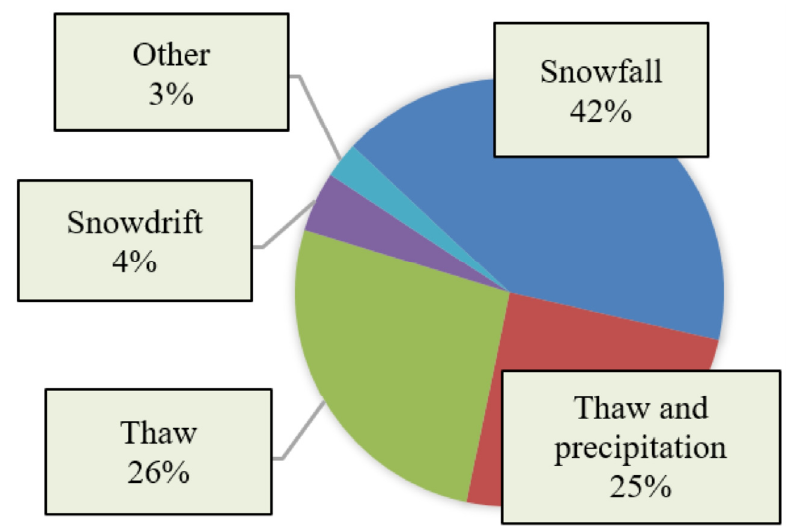
Figure 5. The reasons for avalanches .